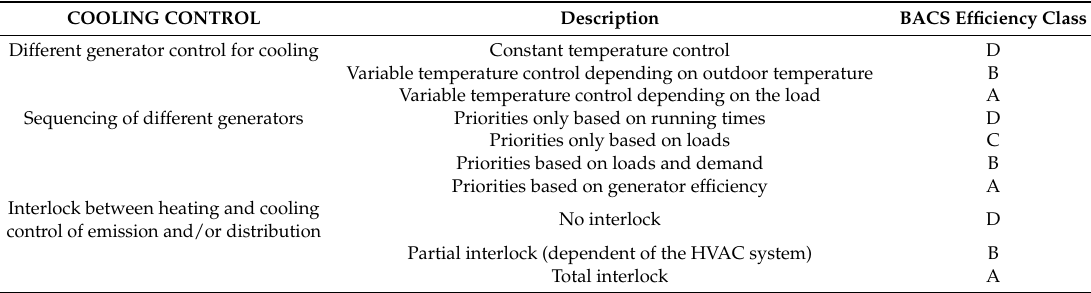
Table 2. The selected BACS control and TBM functions of cooling